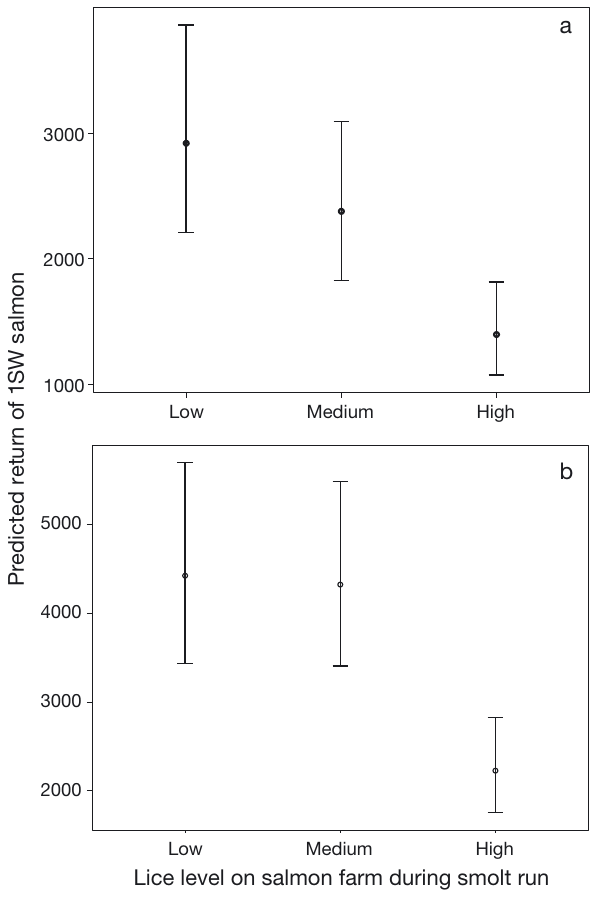
Fig. 4. Predicted return of 1 sea-winter (1SW) Erriff River At- lantic salmon to (a) the river ( S iRiver ) and (b) the Irish coast ( S iCoast ) at 3 levels of sea lice density at the Killary salmon farm during the smolt run. Error bars are 95% confidence